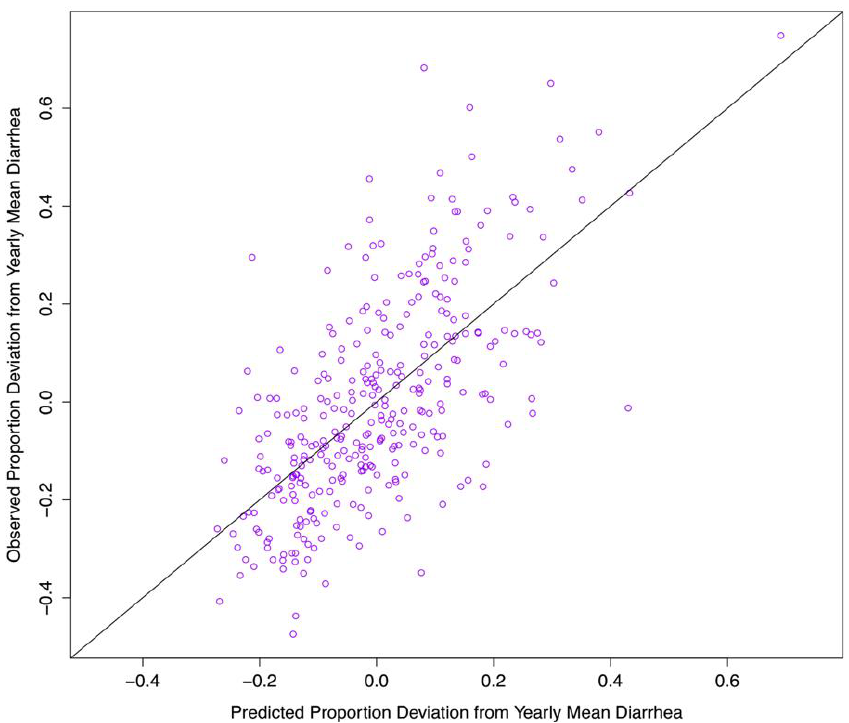
Figure 8. Predicted proportion deviation from yearly average diarrhea in Botswana (1974–2003) plotted against the actual data. Holding out the second half of the dataset and using the first half to estimate the model and predict the second set yields a predicted sum of squares statistic of 0.58. A perfect prediction would line up exactly on the 45° line.